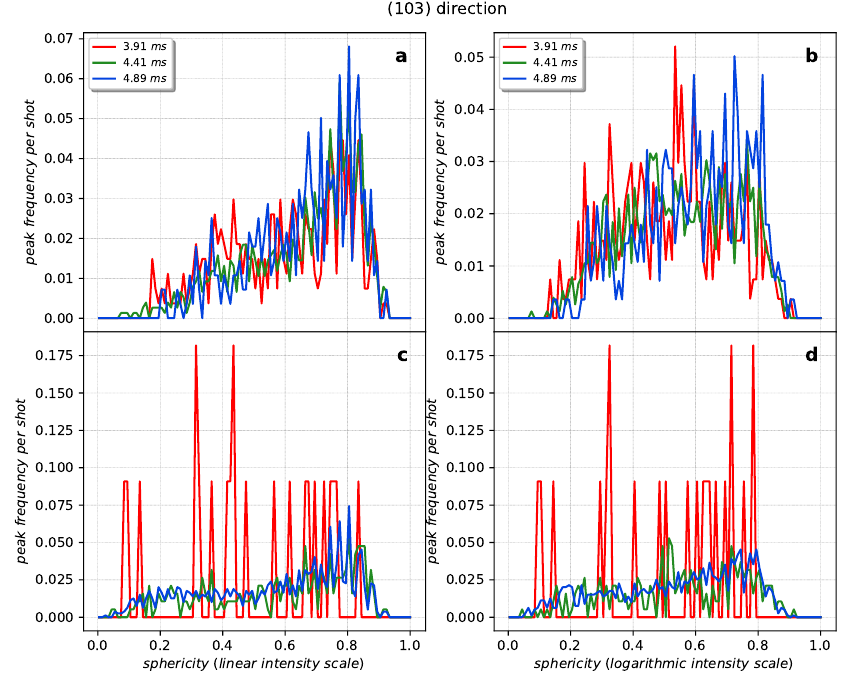
Figure A8. Frequency of a peak appearing with a certain sphericity for the (103) direction for the hits above 50 ADU/pixel ( a ) in linear and ( b ) in logarithmic intensity scales as well as the hits below 50 ADU/pixel ( c ) in linear and ( d ) in logarithmic intensity